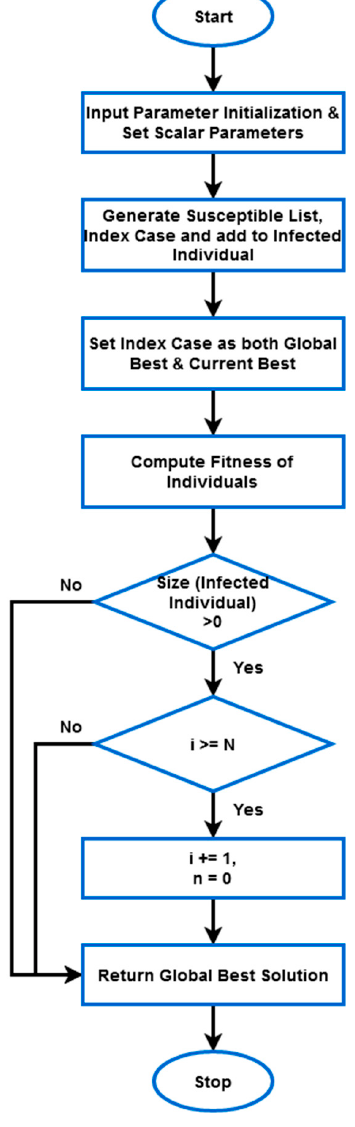
Figure 4. Flow of ZESO algorithm. Based on the obtained solution, the optimal number of features is selected from the normalized SCADA dataset, which can be used for training the sample of classifier. The primary benefits of using this algorithm are as follows: simple to implement, increased